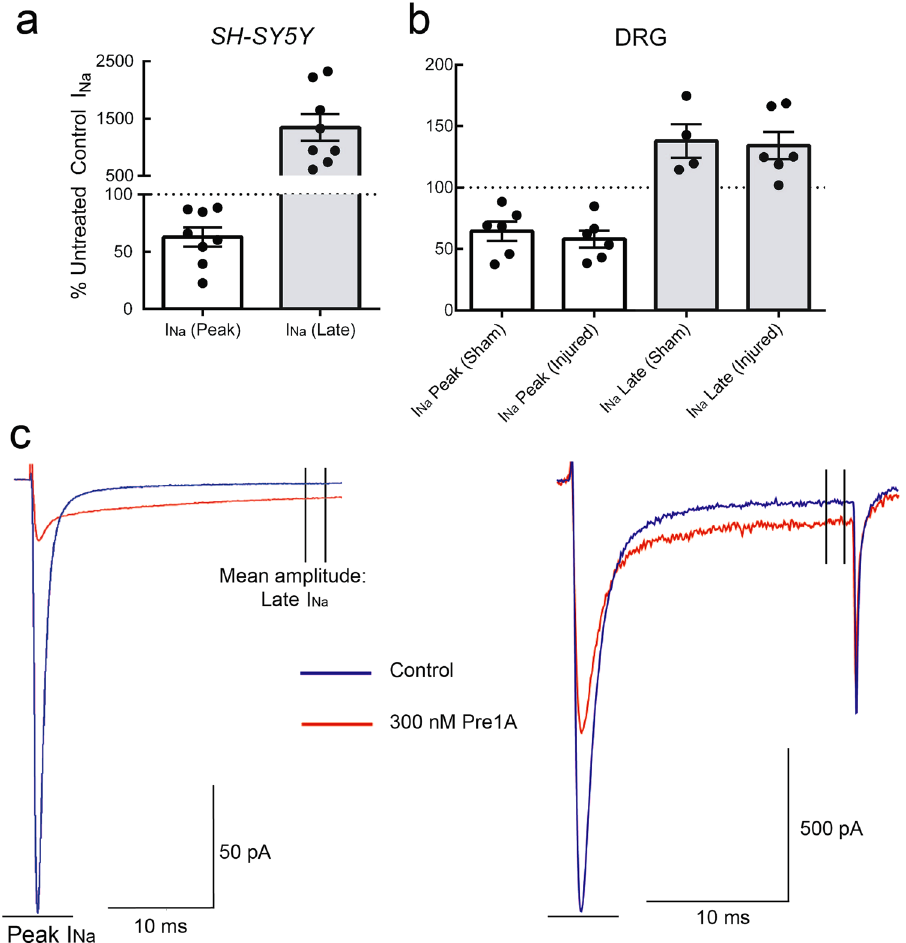
Figure 8. Pre1a inhibits native human and rat Na V currents. (a) Application of 300 nM sPre1a on the human neuroblastoma cell line, SH-SY5Y , inhibits both peak current and fast inactivation, consistent with a Na V 1.3 and Na V 1.7 effect. (b) sPre1a (300 nM) applied to DRG neurons from sham and nerve injured rats resulted in a similar effect to that seen with SH-SY5Y cells. (c) Representative traces showing the effect of Pre1a (300 nM) on SH-SY5Y cell and DRG neuron from sham animal (control = blue; 300 nM sPre1a =